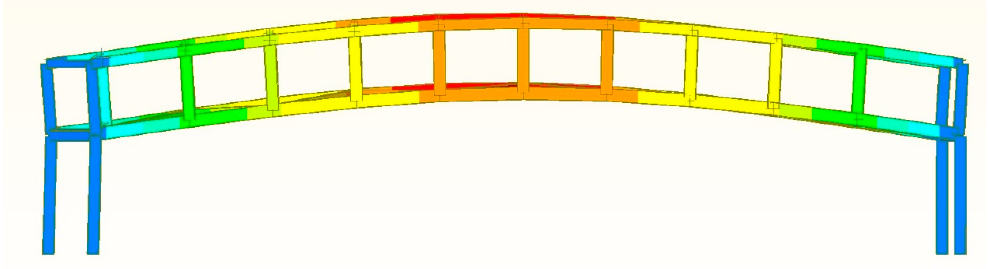
Figure 4. The vertical mode shape of the pedestrian bridge.